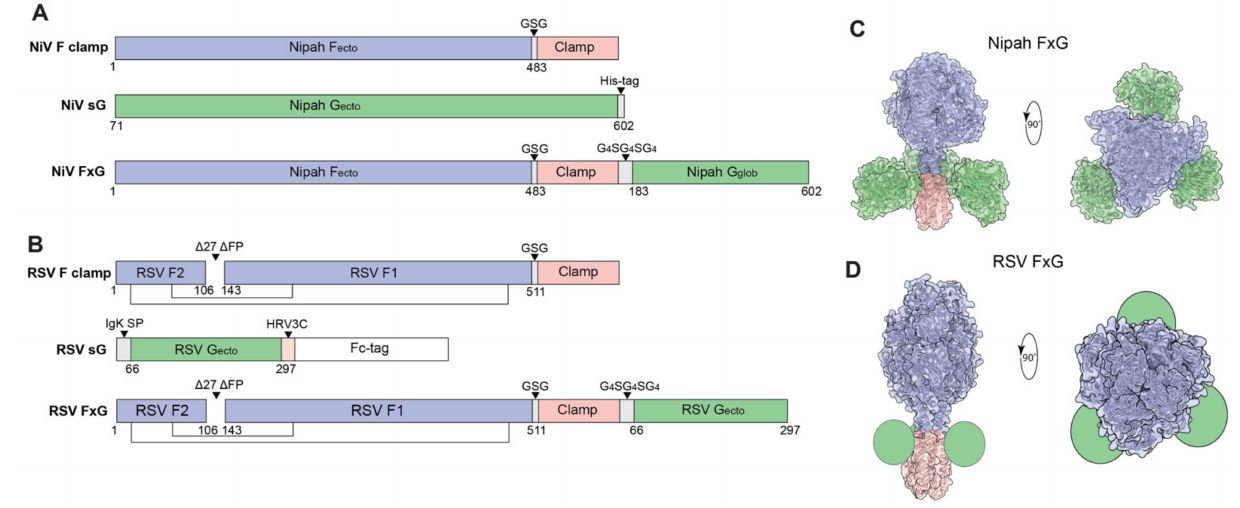
Figure 1. Rational design of NiV and RSV antigens. ( A ) Schematics of prefusion NiV F, NiV sG and NiV FxG antigens. F ectodomains (F ecto ) are coloured in blue, clamp trimerization domain coloured in salmon and G ectodomain (G ecto ) coloured in green. ( B ) Schematics of prefusion RSV F, RSV sG and RSV FxG antigens with the same colouring scheme as in ( A ). The RSV F clamp antigen contains a deletion of the fusion peptide (FP) and peptide 27. The RSV sG antigen is engineered with a human rhinovirus 3C (HRV3C) protease site (orange) to cleave C-terminus Fc purification tag (white). Proposed in silico designs of NiV ( C ) and RSV ( D ) FxG structures are modelled using F structures (NiV PDB 5EVM; RSV PDB 4MMV), G structures (NiV PDB 3D11; RSV G represented as green circles) and clamp structure (PDB 1I5Y) with the same colouring scheme as in ( A ). Structures made using UCSF